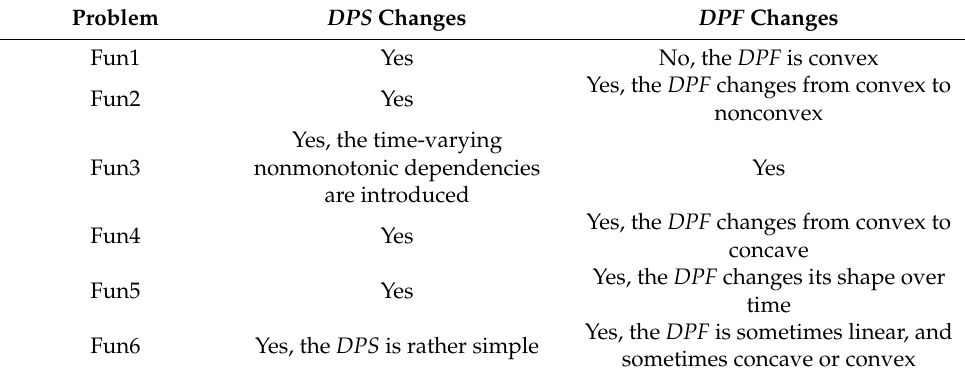
Table 2. The dynamic characteristics of six